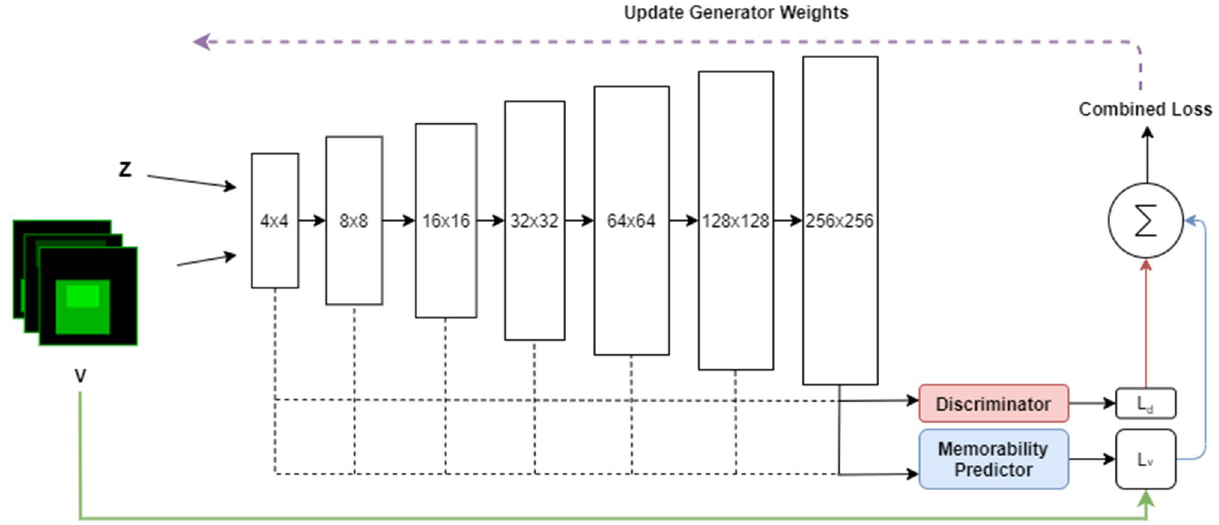
Figure 10. Progressive generator with per-resolution memorability